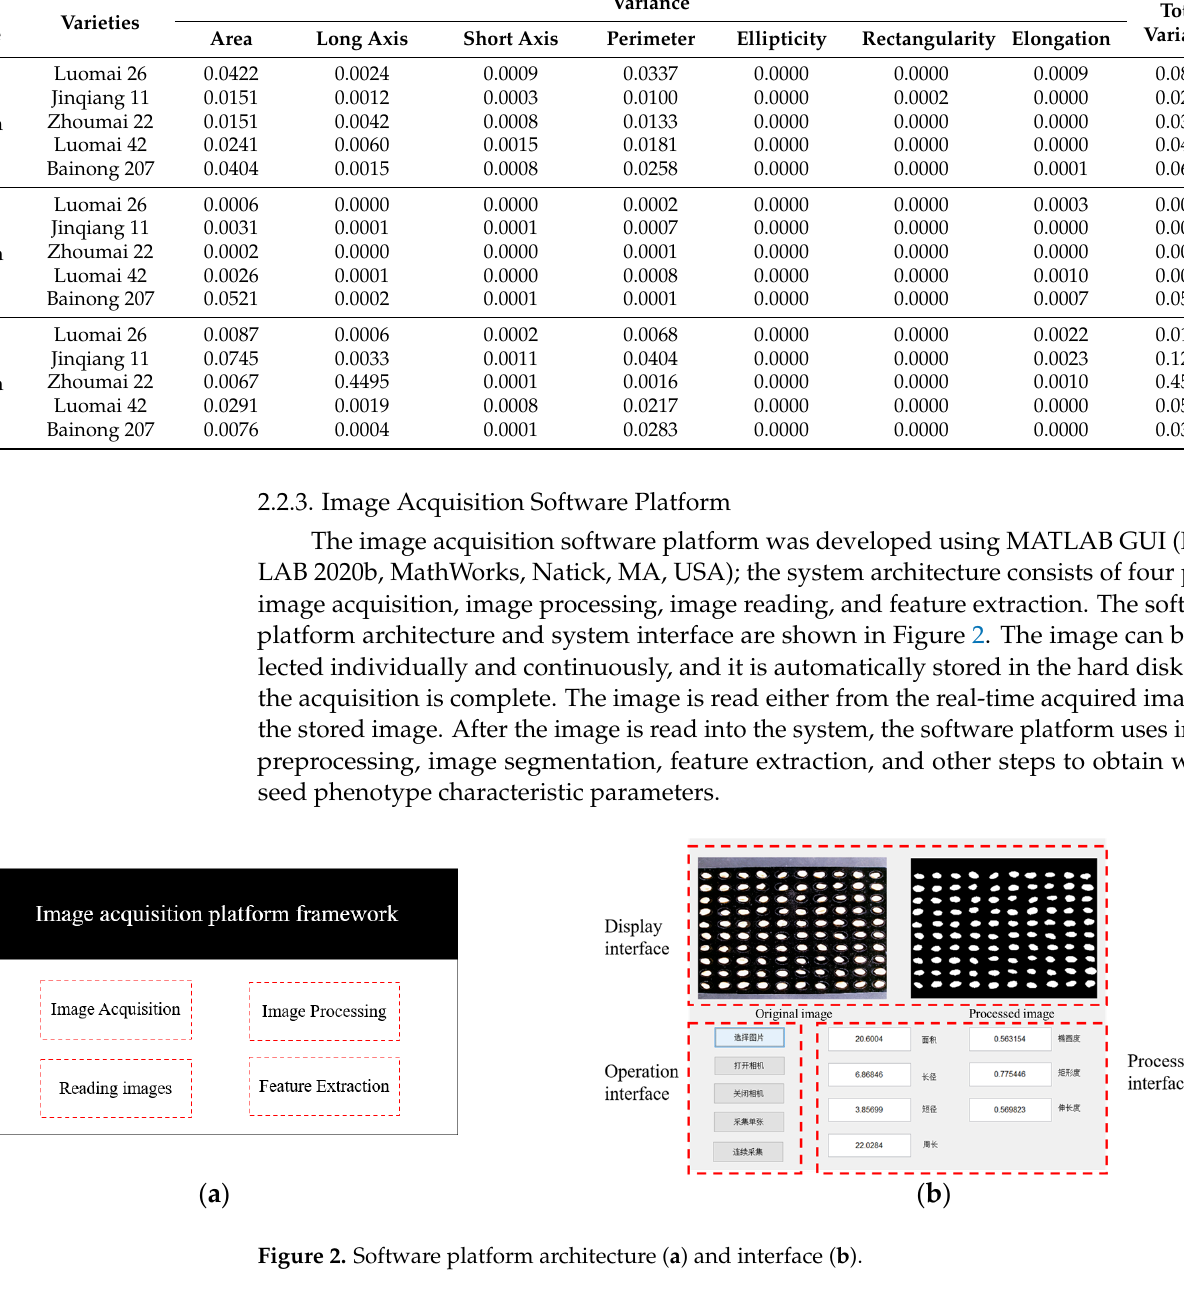
Figure 3. Image processing and analysis block diagram.